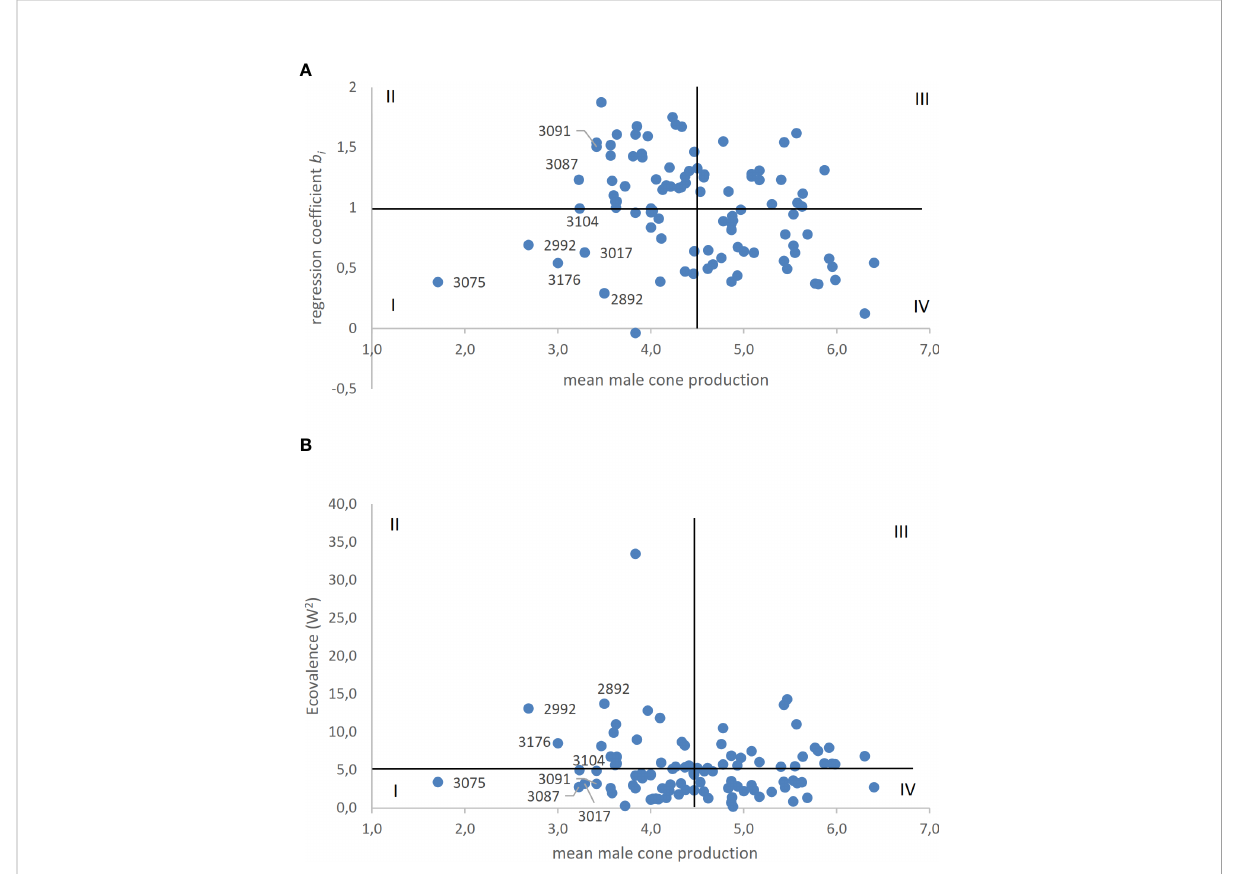
FIGURE 3 (A, B) . The clonal stability regression coef fi cient (A) and Wricke ’ s ecovalence (B) of male cone production of C. sempervirens clones are plotted against mean scores of the same clone. Horizontal line represents the mean of the two stability coef fi cients; vertical line represents the mean score of all